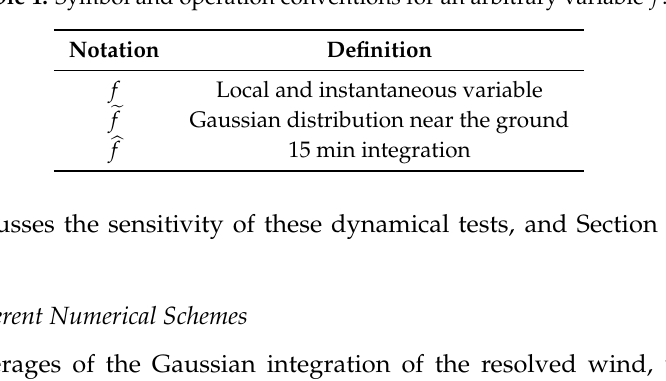
Table 1. Symbol and operation conventions for an arbitrary variable f